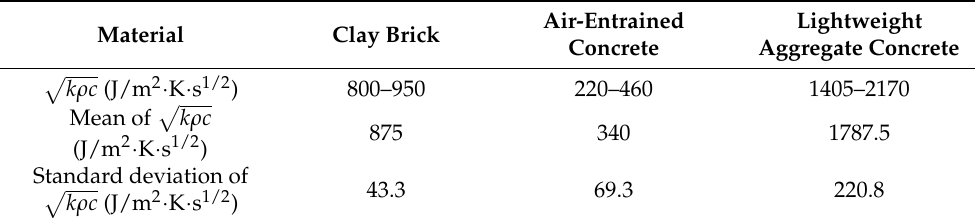
Table 4. Thermal inertia and statistical characteristics of common building